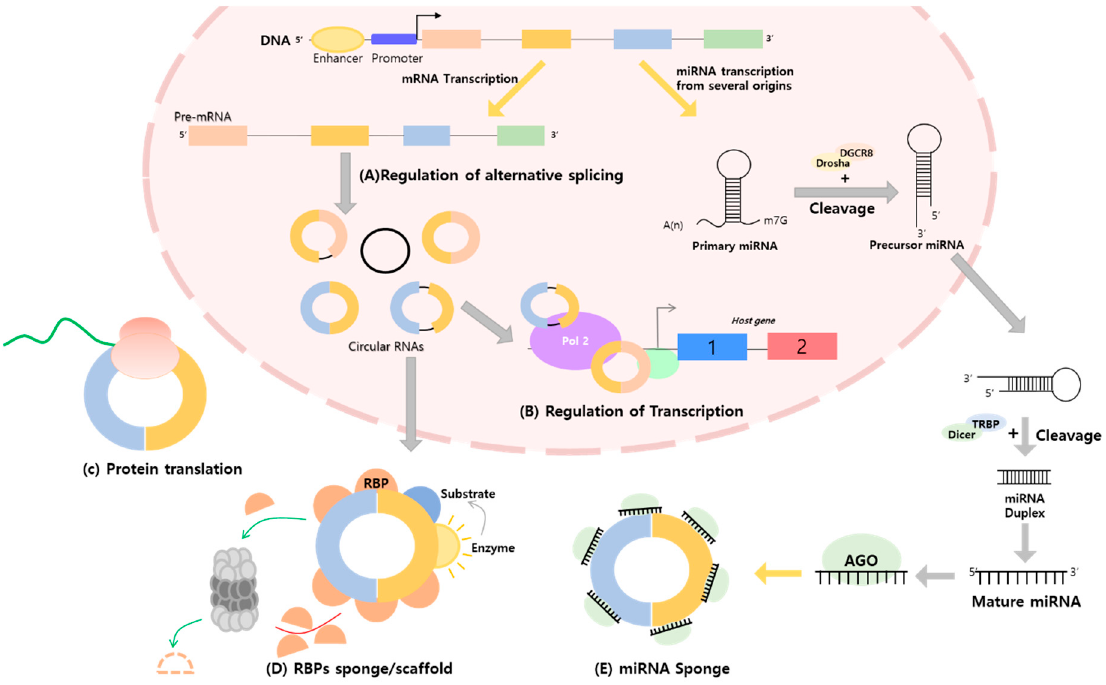
Figure 2. Regulatory processes that involve circular RNAs at the molecular level. Circular RNAs act as significant regulators by interacting with several components that control the vital biological processes, such as: ( A ) Regulation of alternative splicing, ( B ) Regulation of transcription, ( C ) Protein translation, ( D ) RBPs sponge/scaffold ( E ) miRNA sponge. pol 2, RNA polymerase 2; RBP, RNA- binding protein; AGO, argonaute protein.